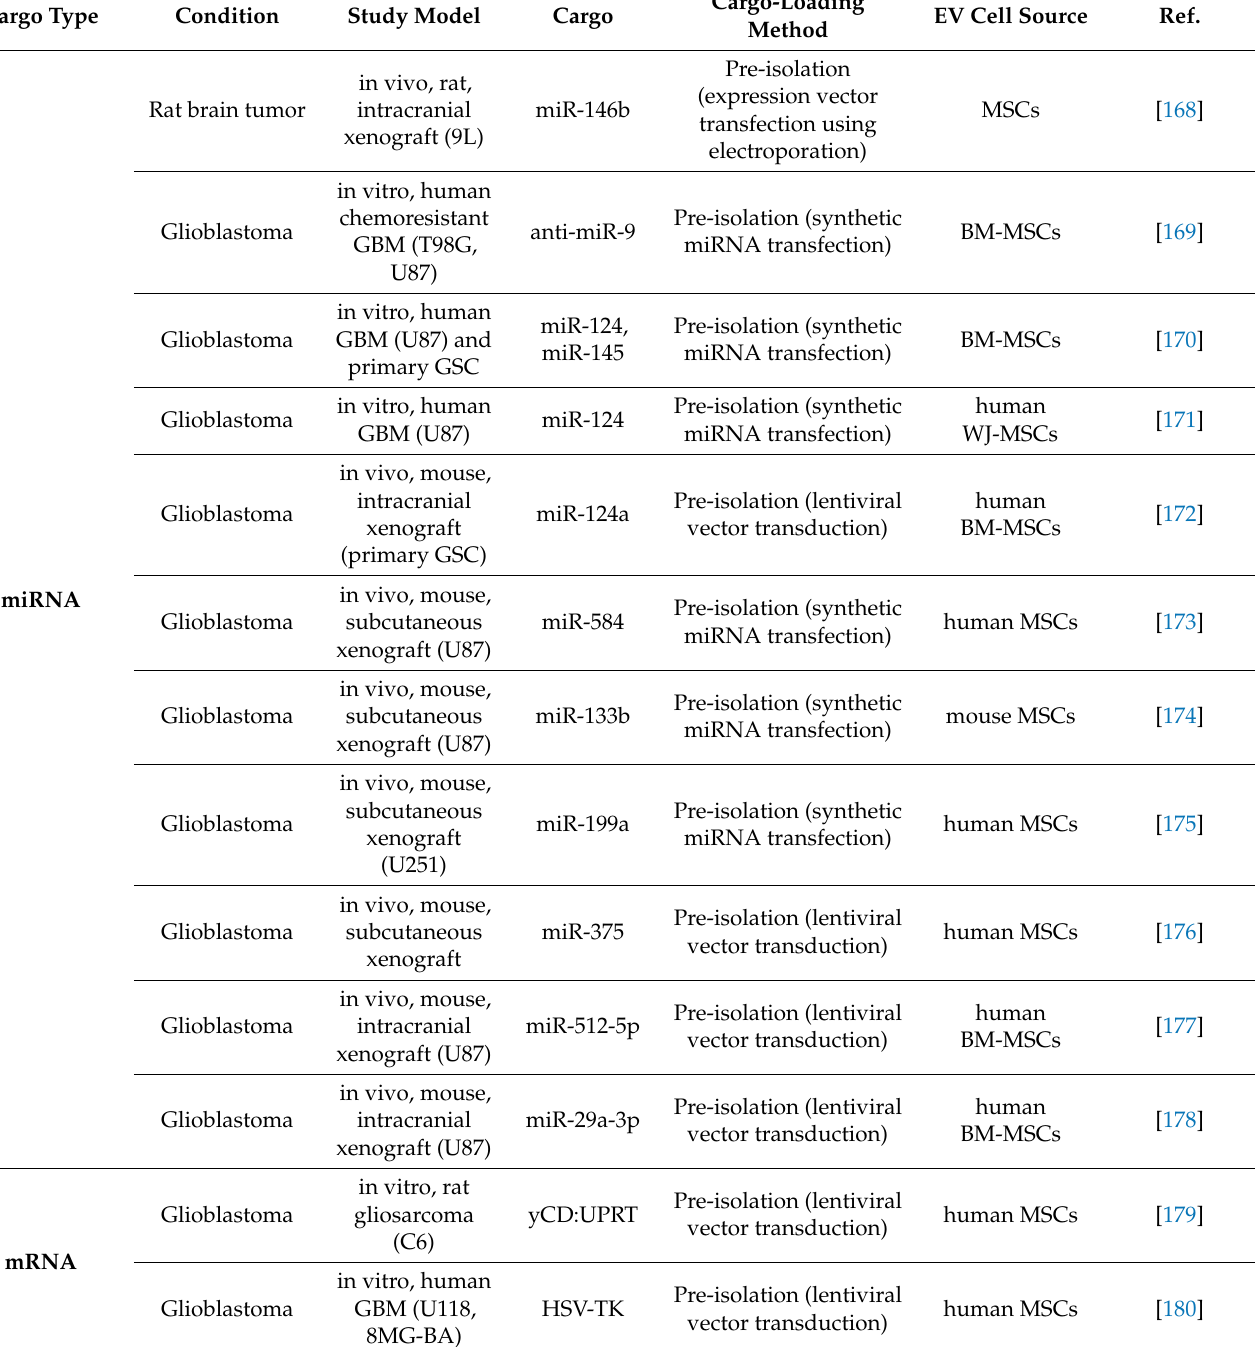
Table 2. Studies on brain tumors using engineered mesenchymal stem cell-derived extracellular vesicles (MSC-EVs) to deliver therapeutic cargos in vitro and in